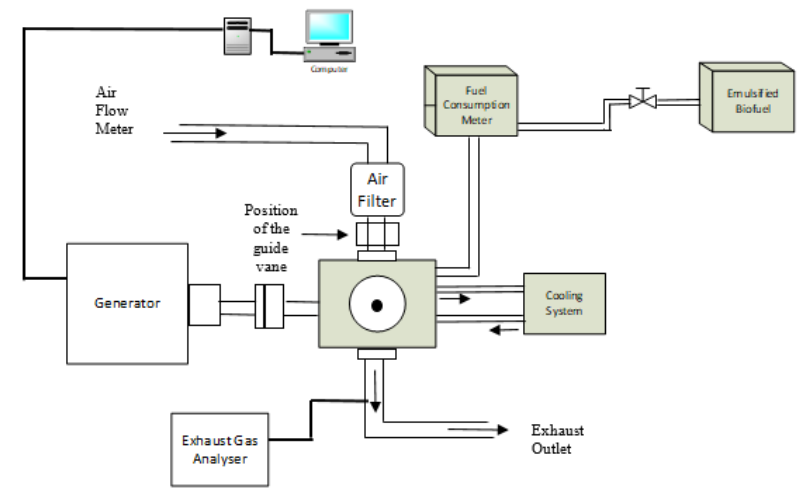
Figure 2. Schematic diagram of the engine setup.